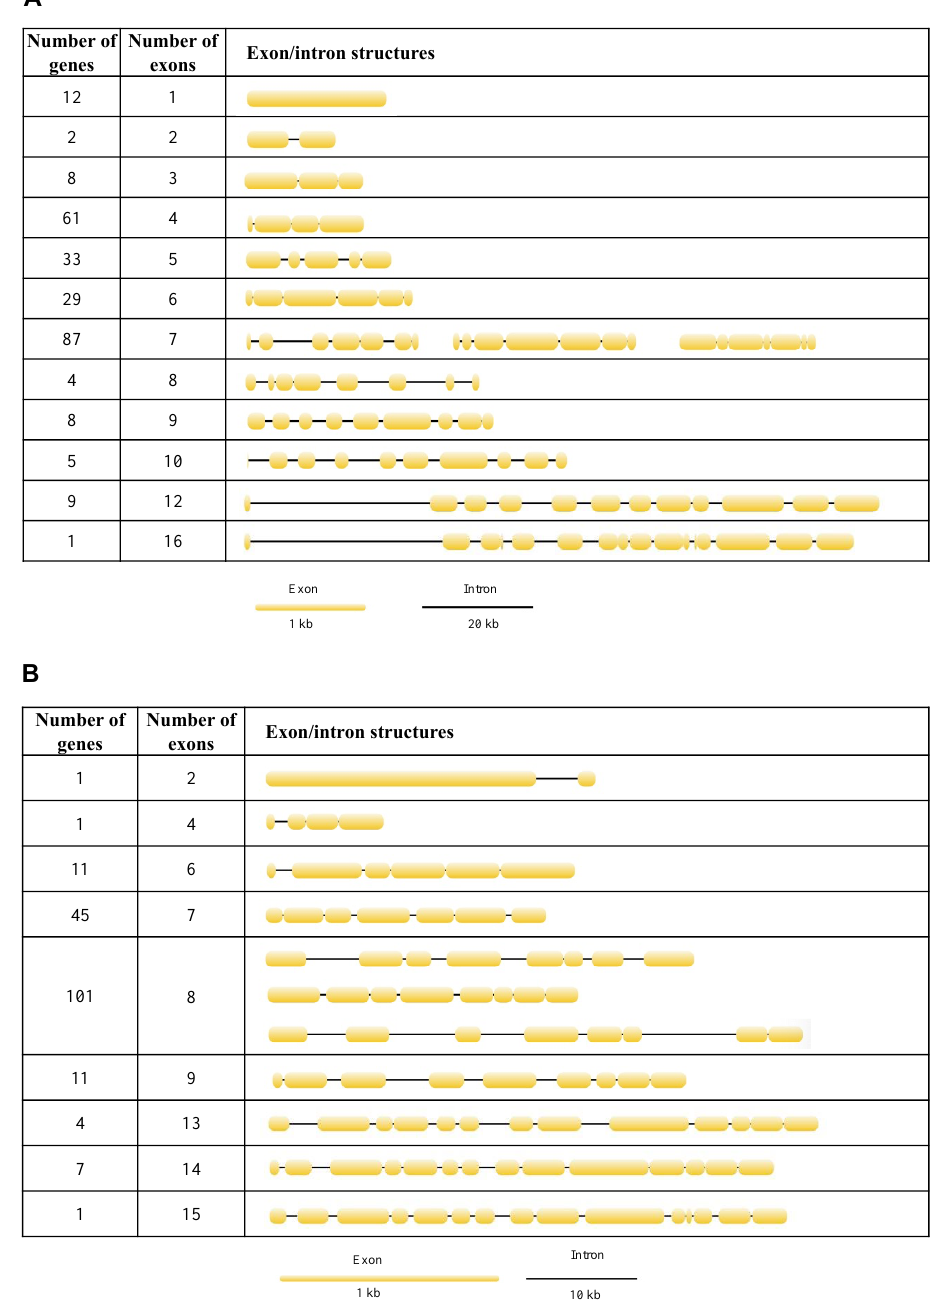
Figure 4. Exon/intron structures of neutral ( A ) and acid ( B ) lipases in 12 fig wasp species.